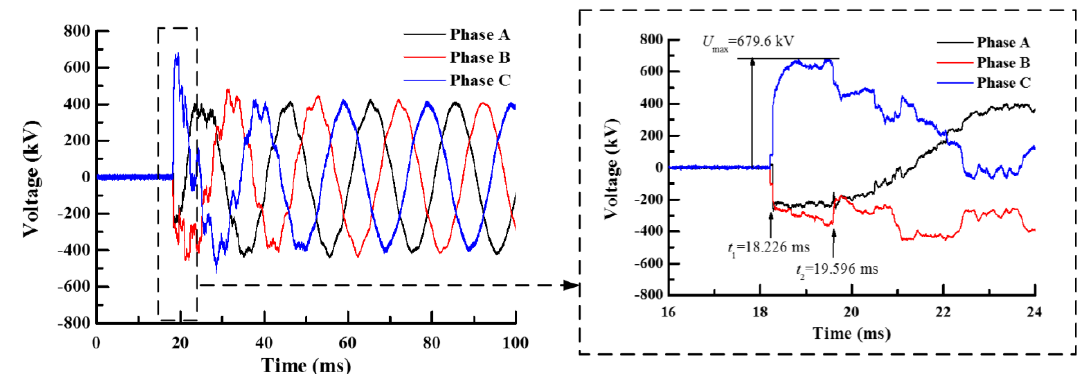
Figure 9. Transient voltage during switching on the Tang-Xiang transmission line.